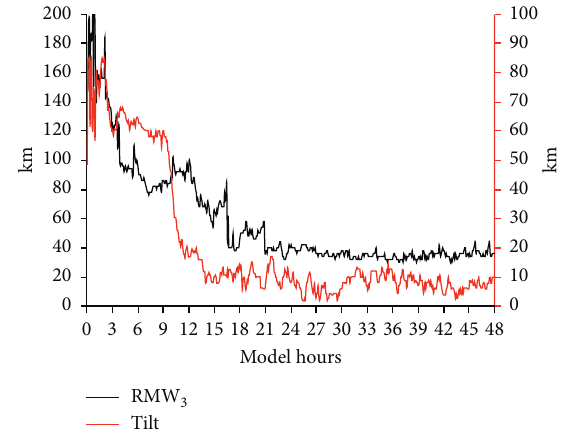
Figure 4: RMW (black line) at the height of 3km and the tilt of the TC center between the sea level and the height of 6.6 km (red line) in the